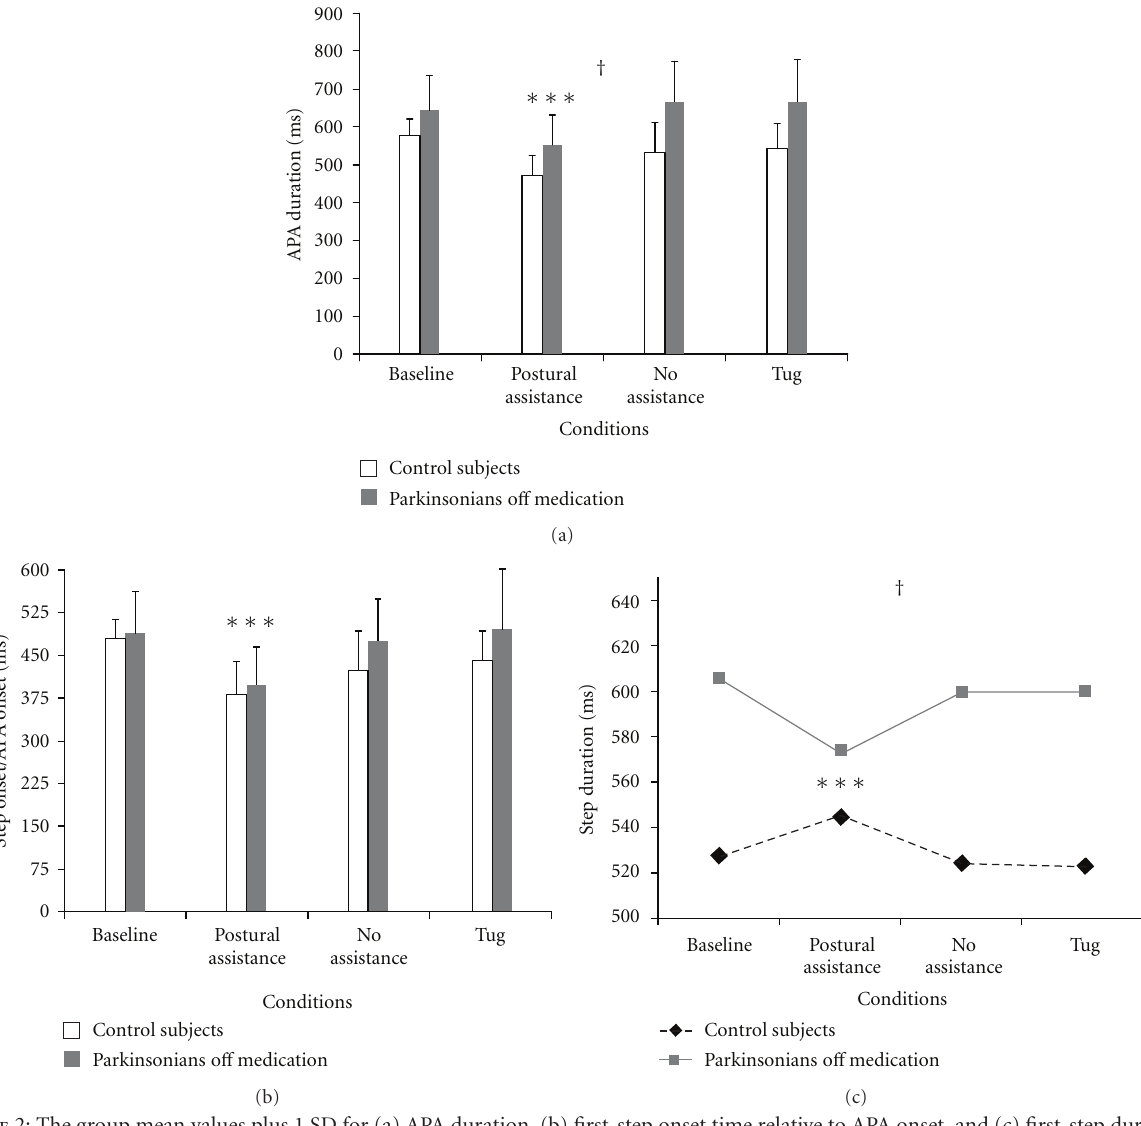
Figure 2: The group mean values plus 1 SD for (a) APA duration, (b) first-step onset time relative to APA onset, and (c) first-step duration in control subjects (CS: white bars) and subjects with Parkinson’s disease o ff medication (o ff : gray bars). The four experimental conditions are initial baseline trials without postural assistance (Baseline), trials with lateral postural assistance (Postural assistance), follow-up trials without postural assistance (No assistance), and trials with a mechanical tug that provided no direct postural assistance (Tug). Data